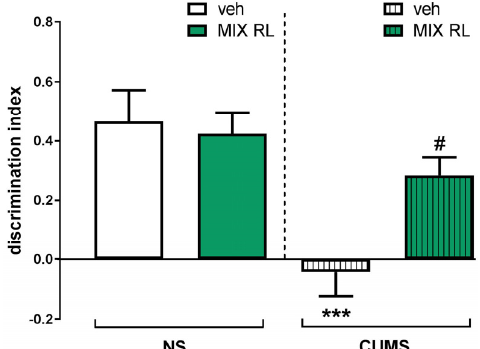
Figure 1. Effect of ( R )-ketamine (1 mg/kg) co-administered with LY341495 (0.3 mg/kg) (mixRL) on the discrimination index in the temporal order memory task in the CUMS model of depression in mice. The values are expressed as the means ± SEM and were analyzed by two-way ANOVA. *** p < 0.001 CUMS main effect; # p < 0.05 CUMS × drug interaction (N = 10). mixRL— (R) -ketamine 1 mg/kg + LY 341495 0.3 mg/kg.